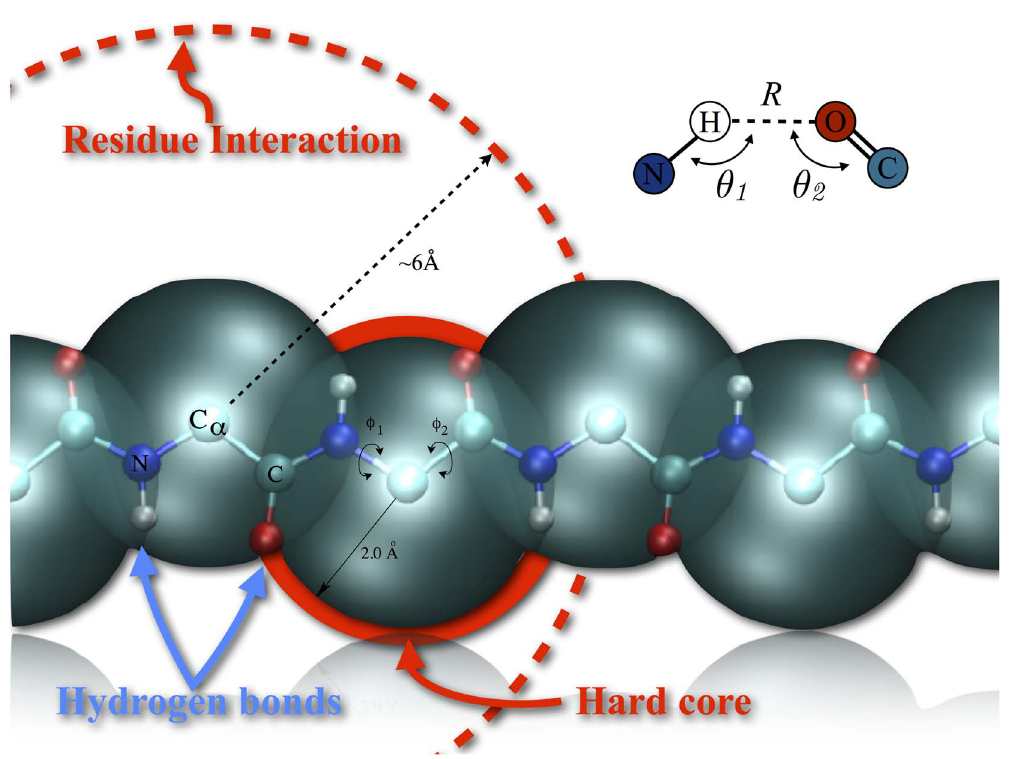
Figure 1. Real-space representation of the backbone of the Caterpillar model. The large blue sphere represent the self-avoidance volume R HC ~ 2 : 0A of the C a atoms, while the interaction radius of each residue is represented by the large dashed circle or radius 6 A˚ (see Eq. S2 in Methods). The H and O atoms interact through a 10–12 Lennard-Jones potential tuned with a quadratic orientation term that selects for alignment of the C, H, O, and N atoms involved in a bond (see top right inset and Eq. S1 in Methods). The backbone fluctuates only around the torsional angles w